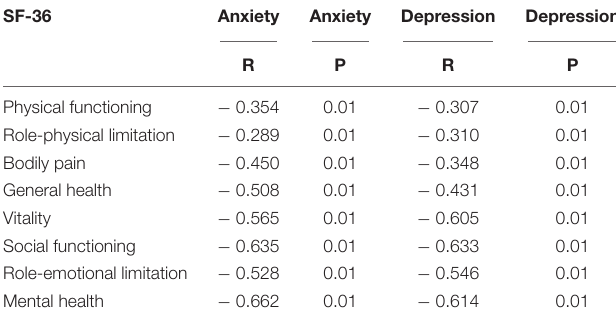
TABLE 6 | Correlations of anxiety and depression with